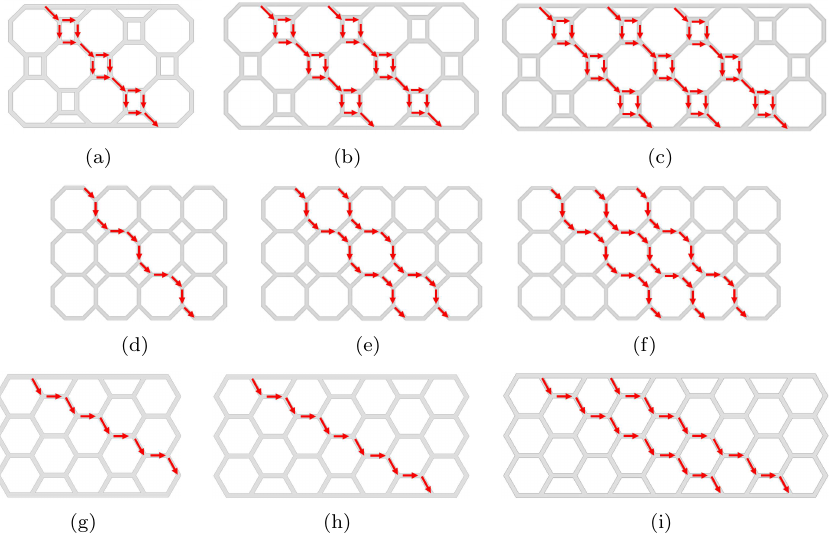
Figure 13. Schematic view of the number of diagonals in dampers P4, P5 and HHSD. ( a ) P4-d1, ( b ) P4-d2, ( c ) P4-d3, ( d ) P5-d1, ( e ) P5-d2, ( f ) P5-d3, ( g ) HHSD-d0, ( h ) HHSD-d1 and ( i ) HHSD-d2. P4-d1, P5-d2 and HHSD-d0 are the original designs analyzed in the previous